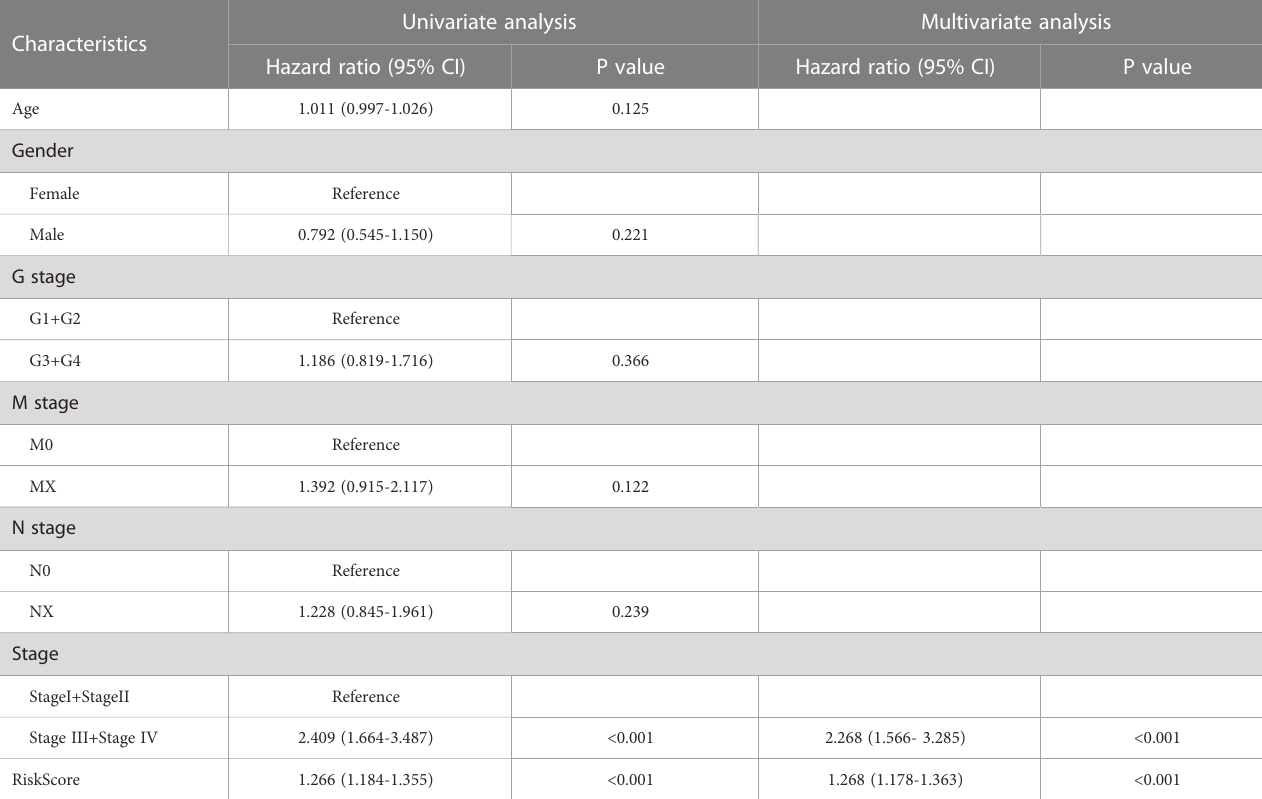
TABLE 2 Results of univariate and multivariate Cox regression analyses of clinical characteristics and risk scores in the TCGA LIHC dataset.